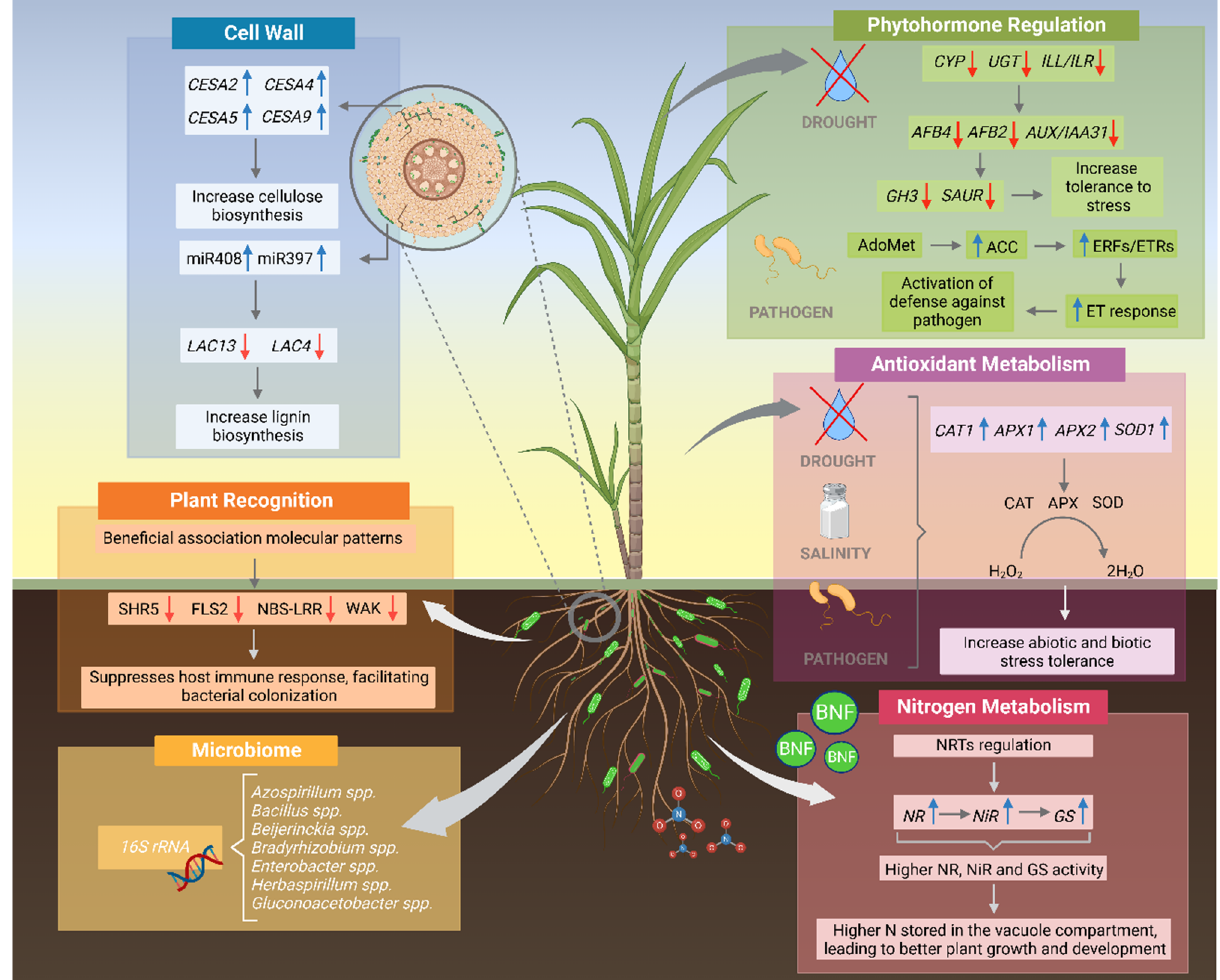
Figure 2. Molecular regulatory models identified in plant–diazotrophic bacteria association. The main studies involve the recognition via 16S rRNA of the plant microbiome and the regulation of plant genes involved in nitrogen metabolism, phytohormone regulation, antioxidant metabolism, cell wall, and plant receptors involved in recognition of diazotrophic bacteria. Certain pathways lead to the promotion of growth and tolerance to biotic and abiotic stresses. Blue arrows: expression is up-regulated; Red arrows: expression is down-regulated; Gray arrow: flow of the pathway. ACC: